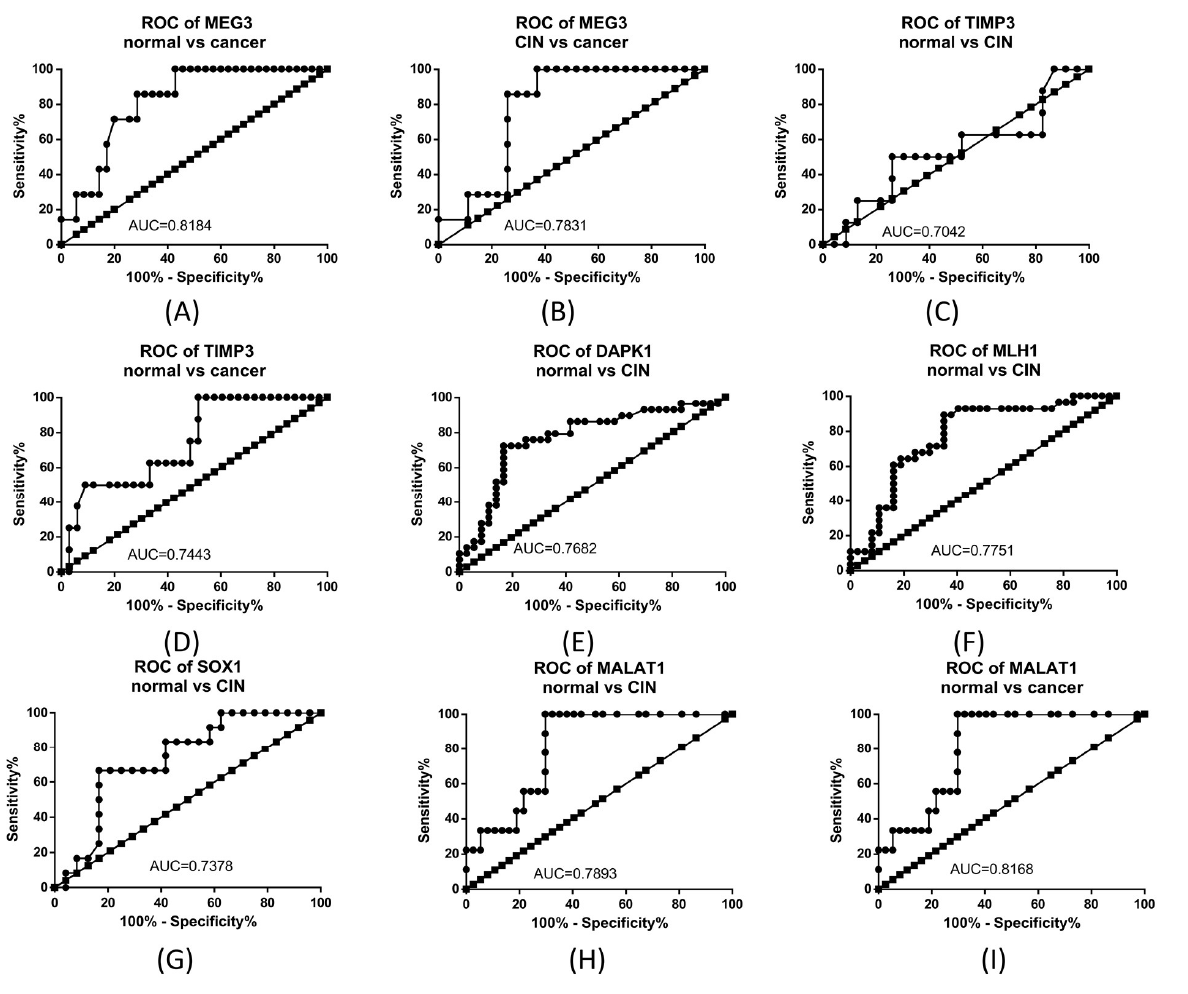
Figure 5. Receiver operating characteristic (ROC) curves for ( A ) MEG3 normal vs. cancer; ( B ) MEG3 CIN vs. cancer; ( C ) TIMP3 normal vs. CIN; ( D ) TIMP3 normal vs. cancer; ( E ) DAPK1 normal vs. CIN; ( F ) MLH1 normal vs. CIN; ( G ) SOX1 normal vs. CIN; ( H ) MALAT1 normal vs. CIN; and ( I ) MALAT1 normal vs. cancer.